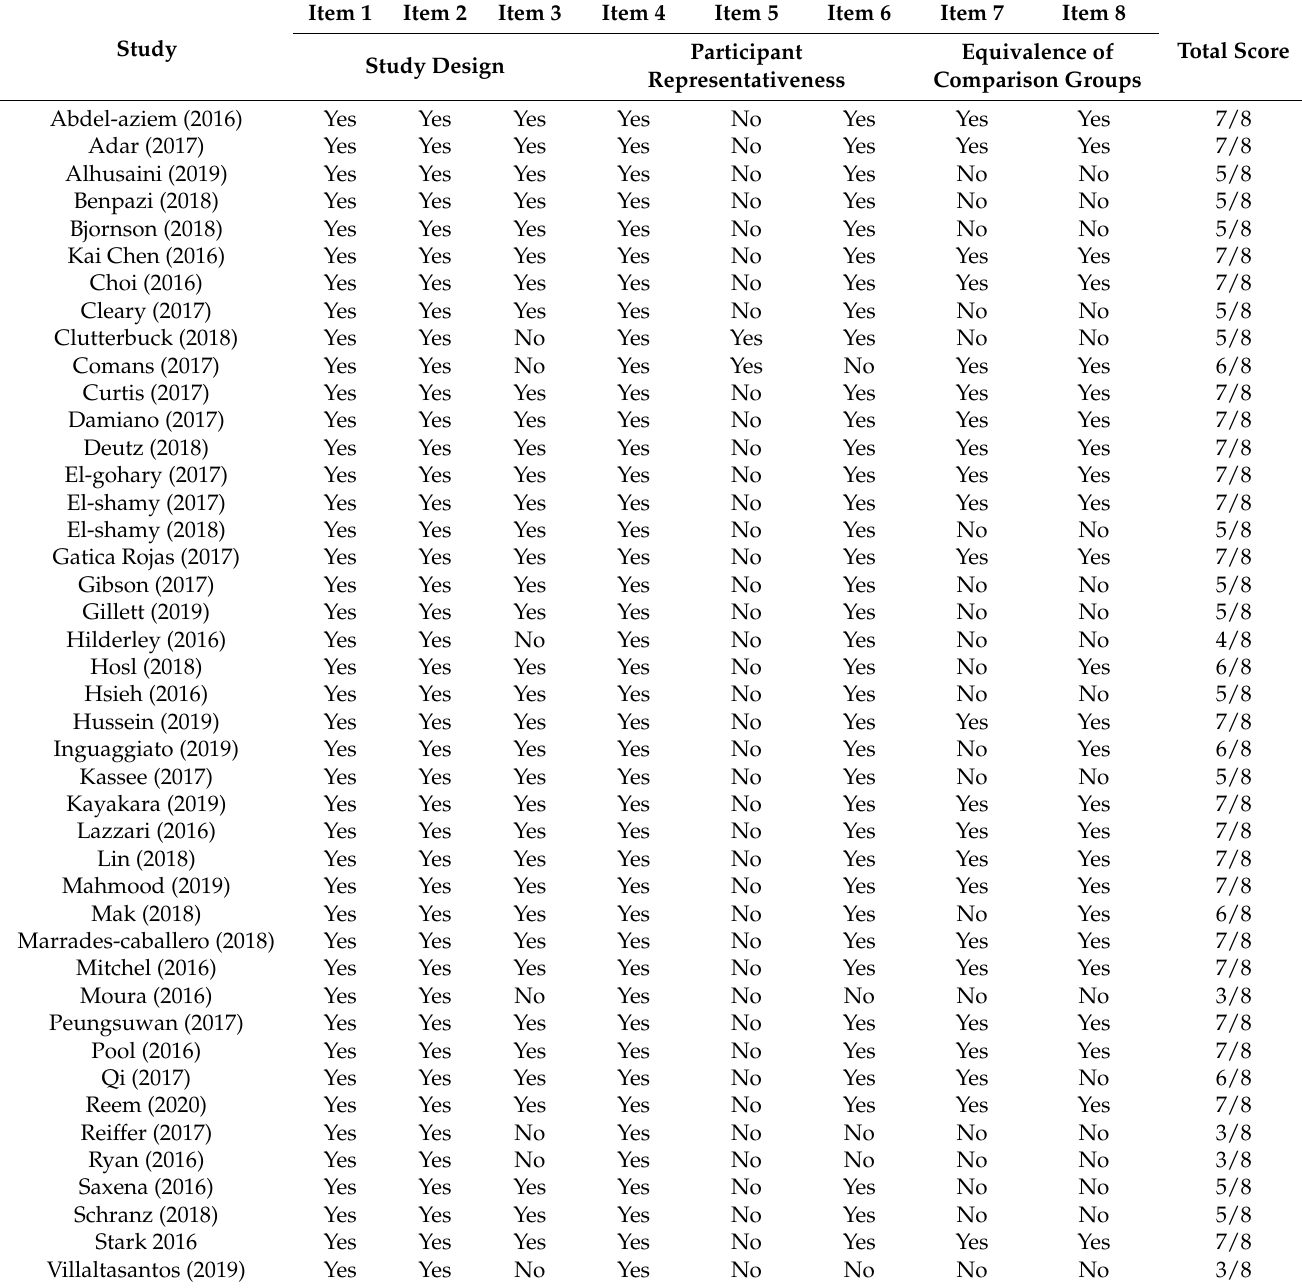
Table 3. Risk of bias analysis with the Evidence Project